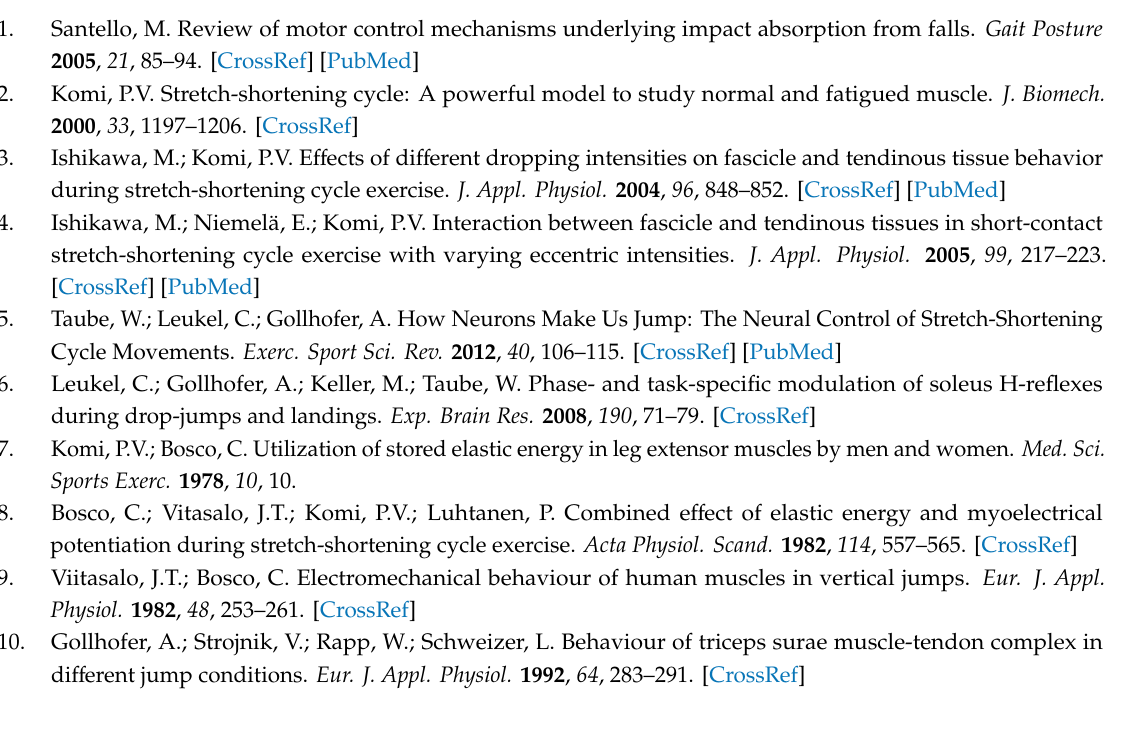
Table S1: Reliability intra-session of the measured variables during the di ff erent drop heights and phases of the drop